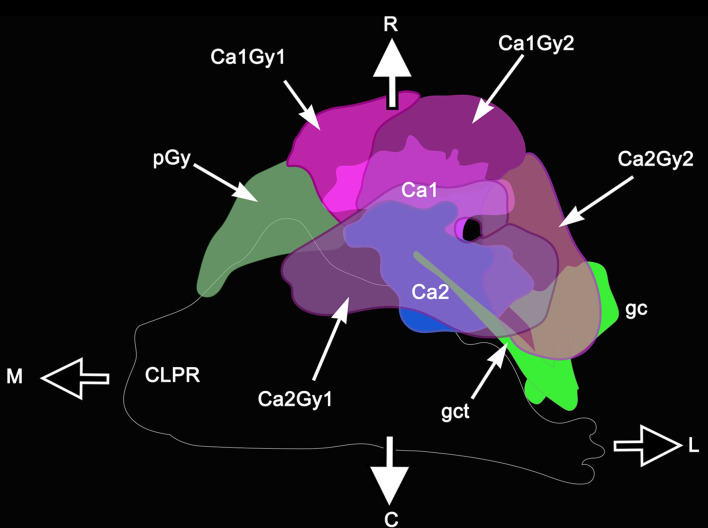
Calyx-gyri topographical relationships.The lateral protocerebrum (minus optic lobes) is viewed from its ventral aspect. Details of the caudal lateral protocerebrum (CLPR) are omitted. Ca1, Ca2, calyces 1 and 2; Ca1Gy1, the medial of two gyri associated with Ca1; Ca1Gy2, second more lateral gyrus; Ca2Gy1, medio-ventral gyrus associated with Ca2; Ca2Gy2, second more lateral gyrus associated with Ca2. pGy, proximal gyrus. Axes: R, rostral; C, caudal; L, lateral (distal); M, medial (proximal; see also Figure 1a–c).